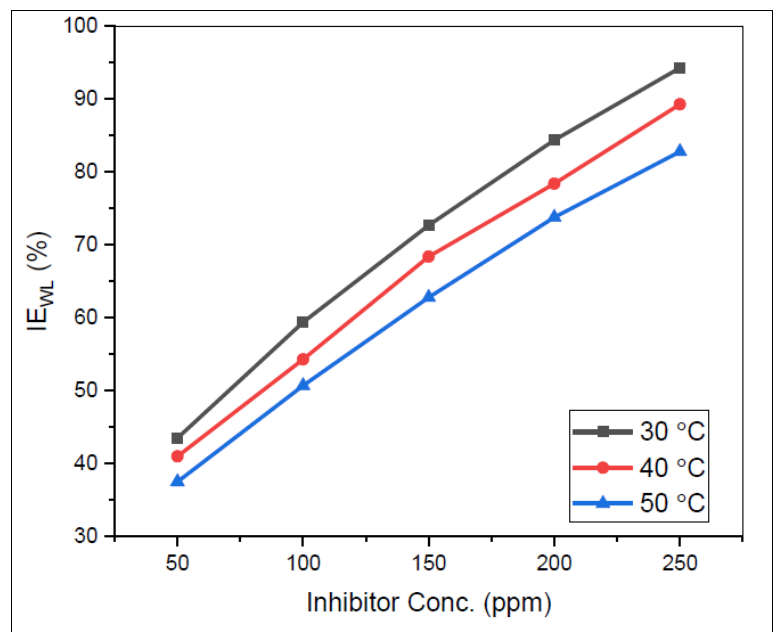
Figure 3. Relationship between inhibition efficiency ( 𝐼𝐸 𝑊𝐿 ) and inhibitor concentration for various temperatures of Justicia secunda leaf extracts. Reprinted from [49].